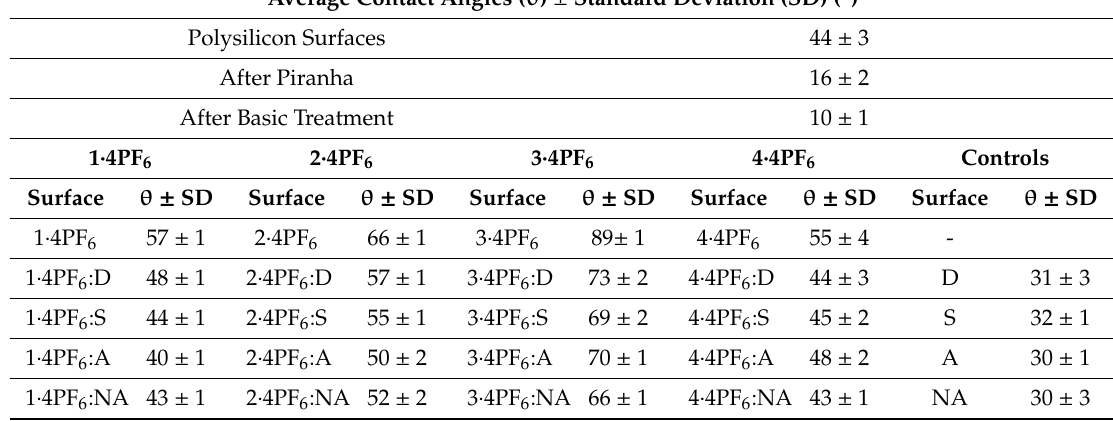
Table 1. Contact angles measurements with the corresponding standard deviation of polysilicon surfaces functionalized with 1 · 4PF 6 – 4 · 4PF 6 , and subsequent incorporation of neurotransmitters D , S , A and NA , and control